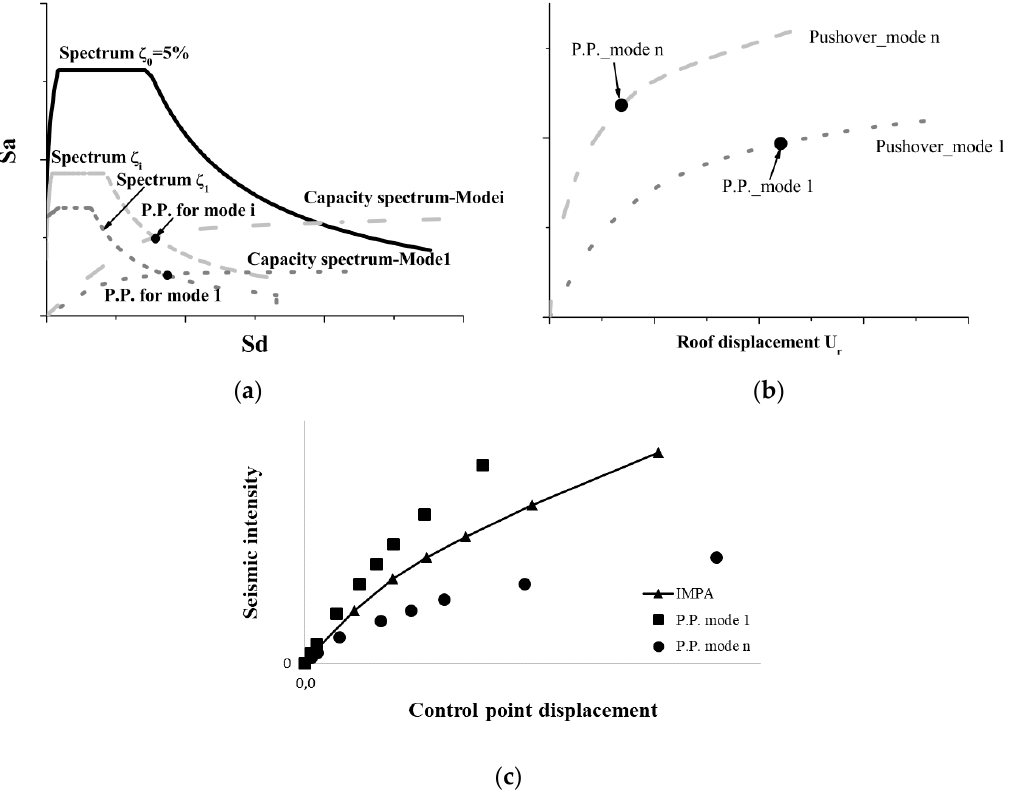
Figure 1. IMPA procedure. ( a ) Evaluation of the performance points (P.P.) for each capacity curve that belongs to the pushover analysis: proportional to Mode 1. Mode n . ( b ) Evaluation of the P.P. for each capacity curve: e.g., via C.S.M. ( c ) Capacity curve plotted in the u r -intensity plane (u r is the displacement of the monitoring point along the investigated direction, e.g., the transverse direction).